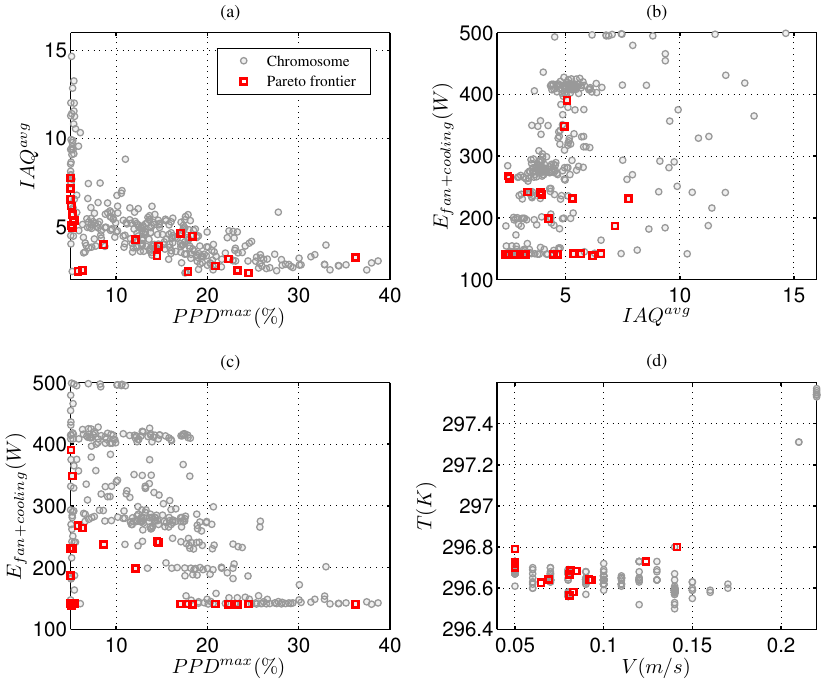
Figure 9. Limited bi-dimensional projections of the 3D objective space: ( a ) PPD–IAQ; ( b ) IAQ–Energy; ( c ) PPD–Energy; and ( d ) control variables space.